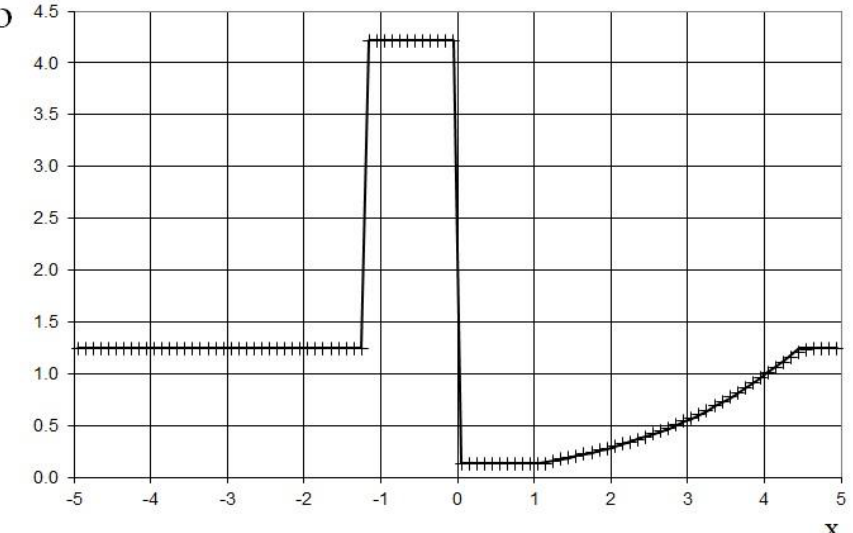
Figure 29. Density plot for the problem (54): the exact solution (line), and the present method